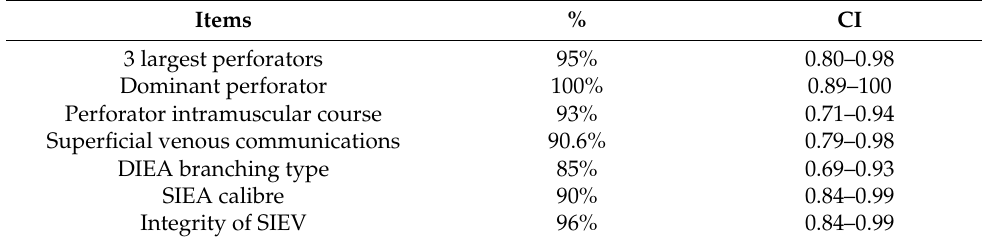
Table 1. Performance of cCT versus